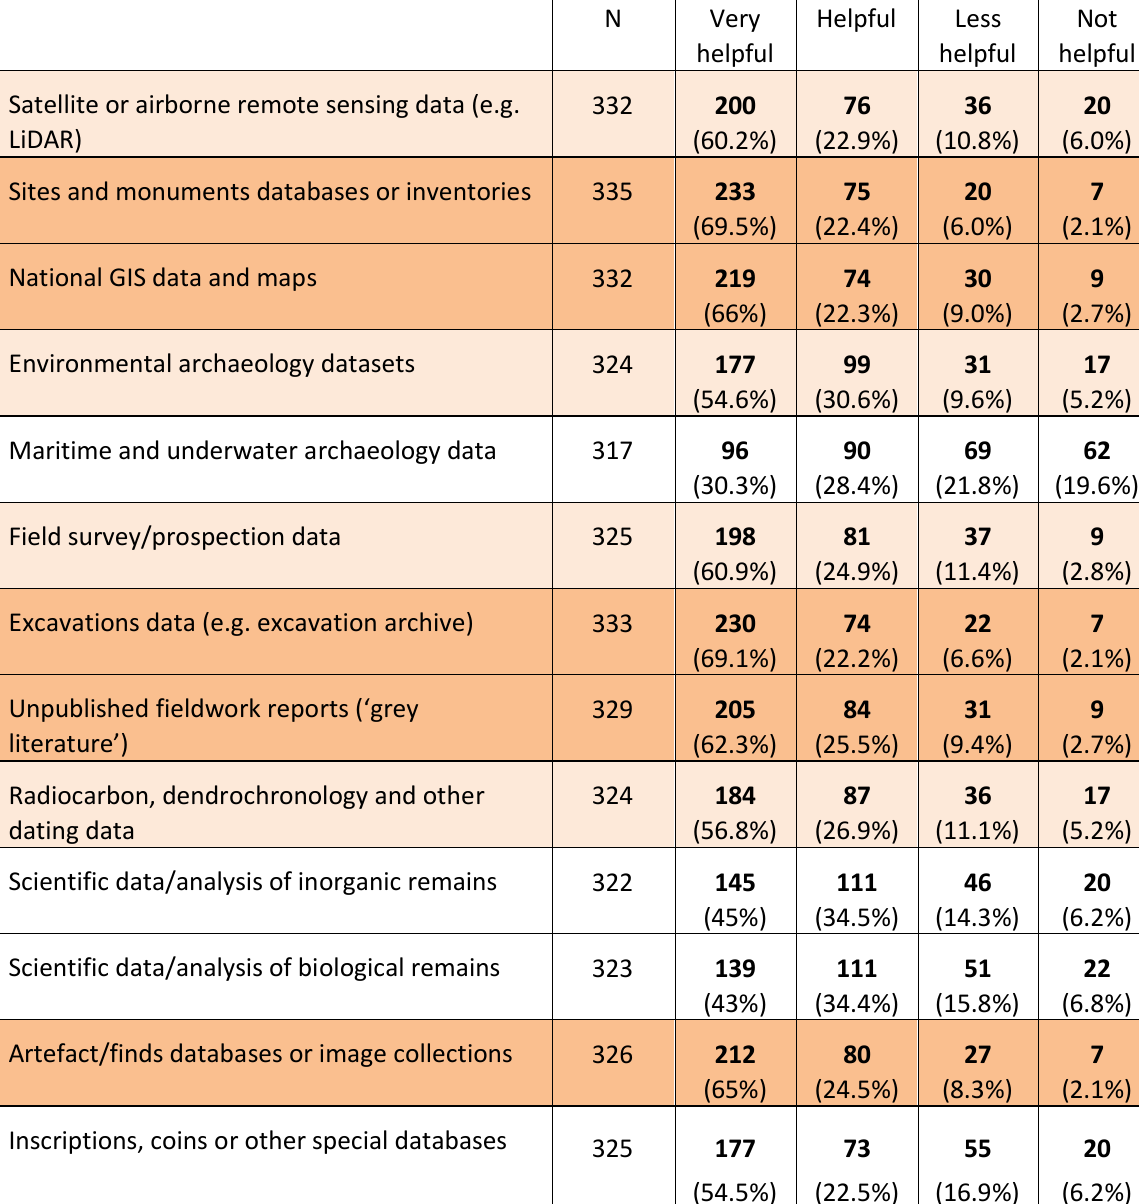
Table 20.2 : Results for item-level search & access on the ARIADNEplus portal for different types of data (N =